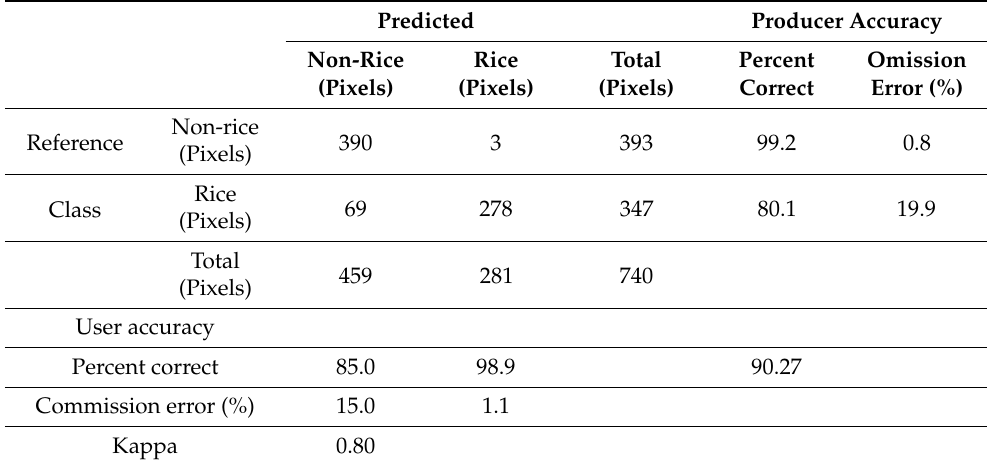
Table 3. Confusion matrix for the rice classification in Peninsular Malaysia by NESEA-RICE 10 [40].